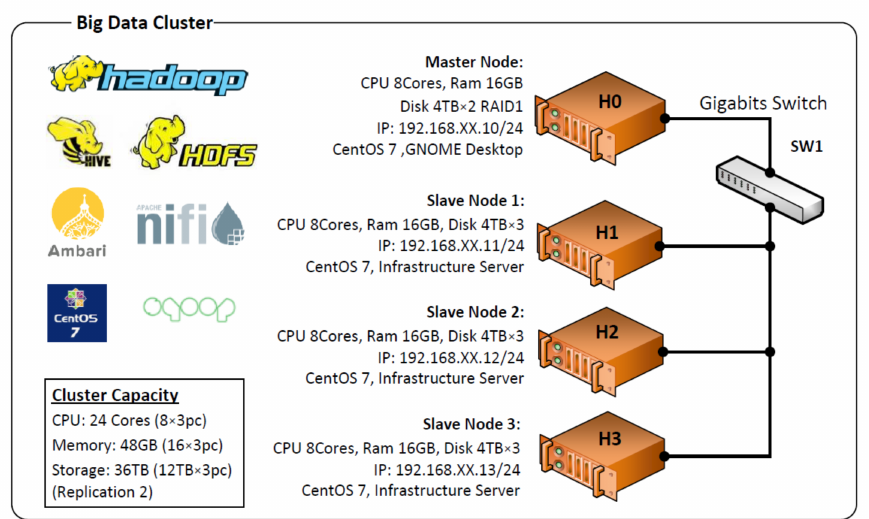
Figure 3. Hardware and software specifications of the big data cluster.